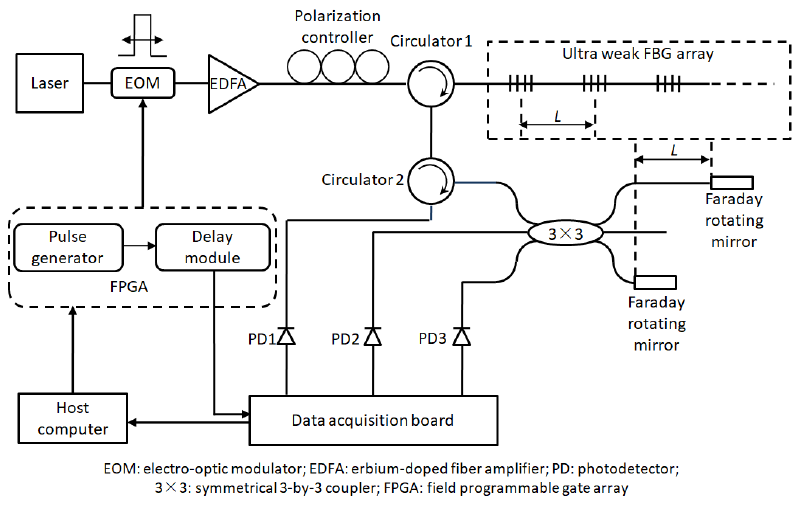
Figure 1. Sensing principle of distributed vibration detection-based on ultra-weak FBG array.